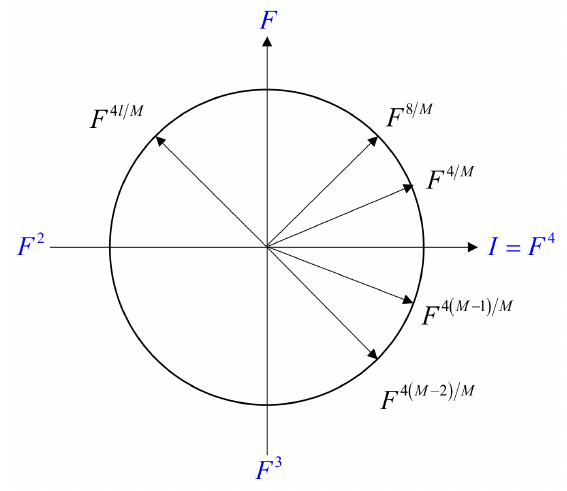
Figure 1. Time-frequency denotation of the M-WFRFT